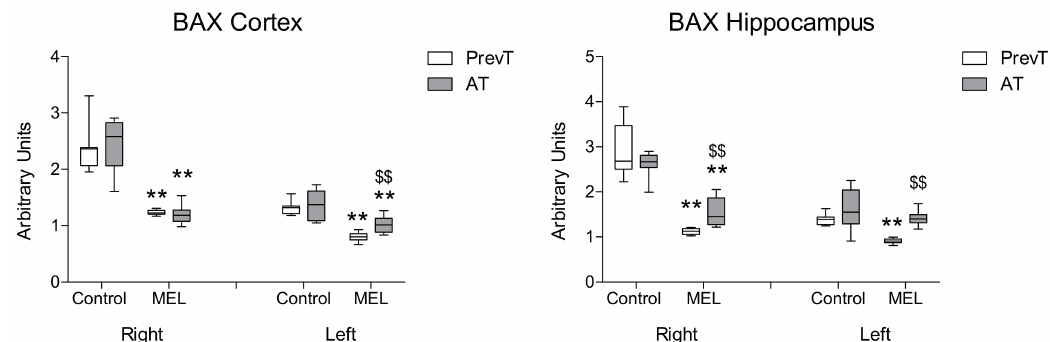
Figure 5. Right and left cortical and hippocampal mRNA expression of BAX in 18-month-old rats in control (non-treated) conditions, after treatment with a daily dose of melatonin (10 mg/kg b.w.) from 24 h before until 7 days after surgery (PrevT), and treated only after surgery during 7 days (AT). Each value represents the median, interquartile and full range of five determinations performed in duplicate. ** p < 0.01 with respect to the values obtained in the control group; $$ p < 0.01 with respect to the values obtained in the PrevT group.